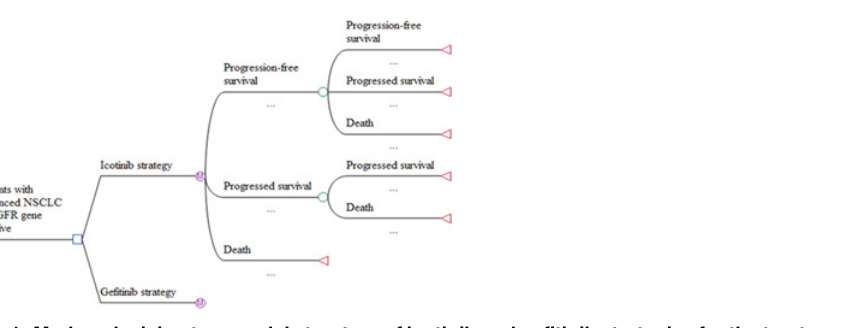
Fig 1. Markov decision tree model structure of icotinib and gefitinib strategies for the treatment of advanced NSCLC.